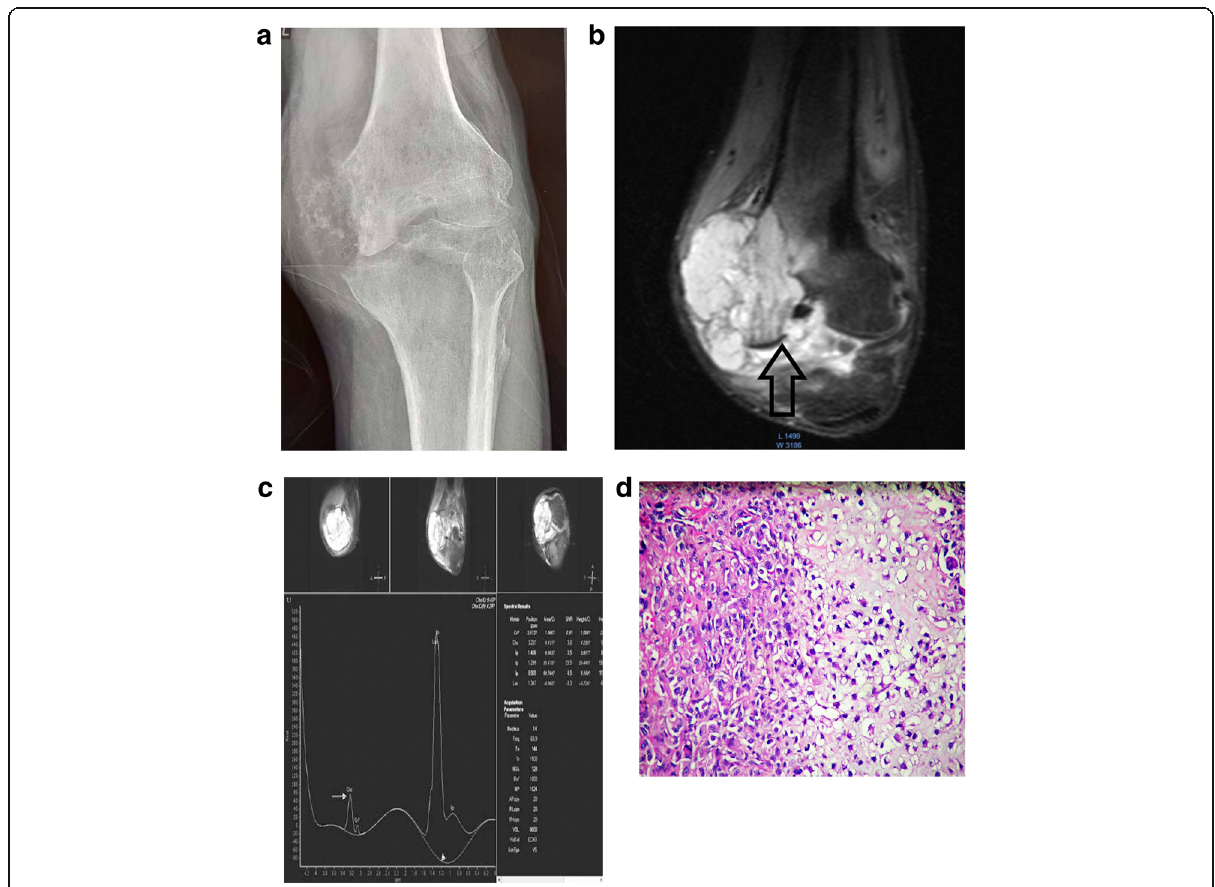
Fig. 3 A 22-year-old male patient with swelling in the left knee. a AP radiograph of the left knee. Lytic destruction (arrow) of medial femoral condyle with erosion of medial tibial plateau. b STIR image shows an eccentric hyper intense epimetaphyseal destructive lesion with soft tissue mass in the distal femur (arrow). c MRS shows discrete small choline peak at 3.2 ppm. d HNE 200× show lobules of malignant cartilage with spindling at the periphery and osteoid formation suggestive of chondrogenic